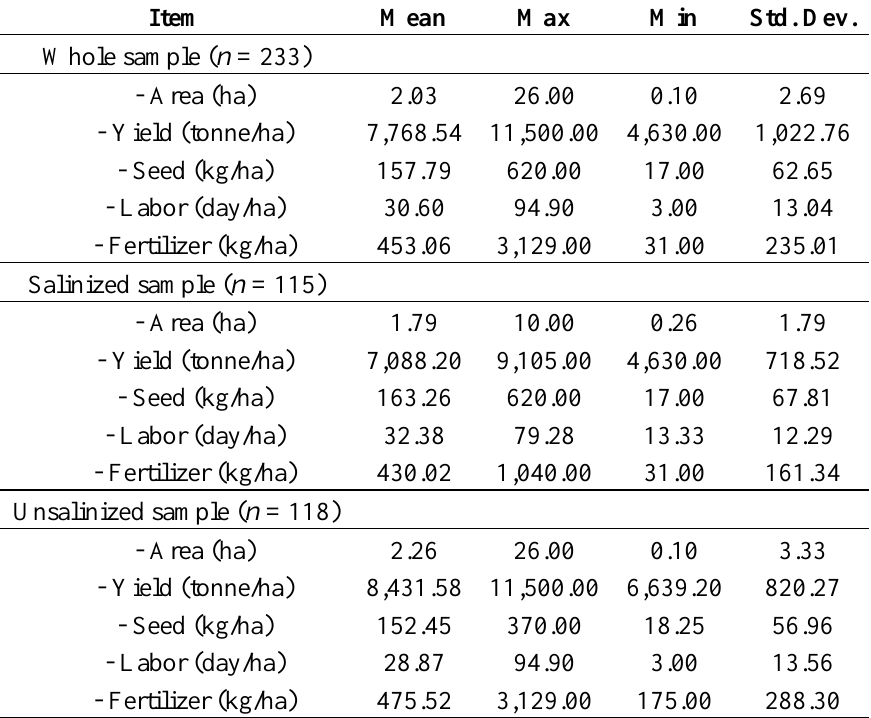
Table A1. Summary of statistical variables in the rice production model.